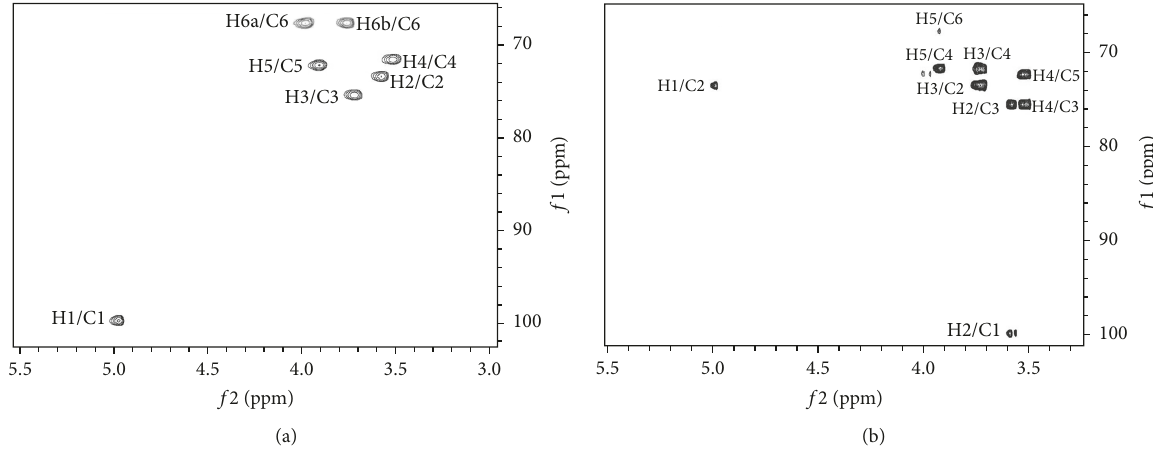
Figure 4: 2D NMR spectrum of purified dextran from W. confusa R003 recorded at 125MHz in D 2 O at 40 ∘ C: (a) HSQC spectrum; (b) H2BC